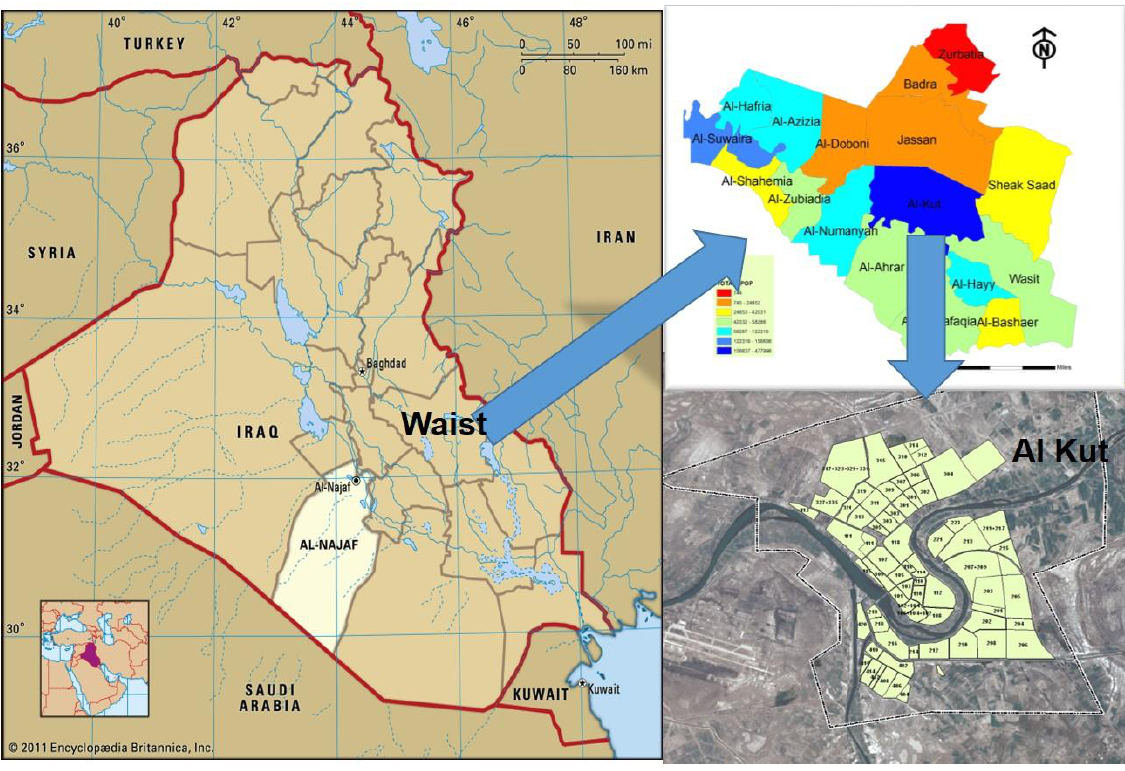
Fig. 1. Location map of Al-Kut city